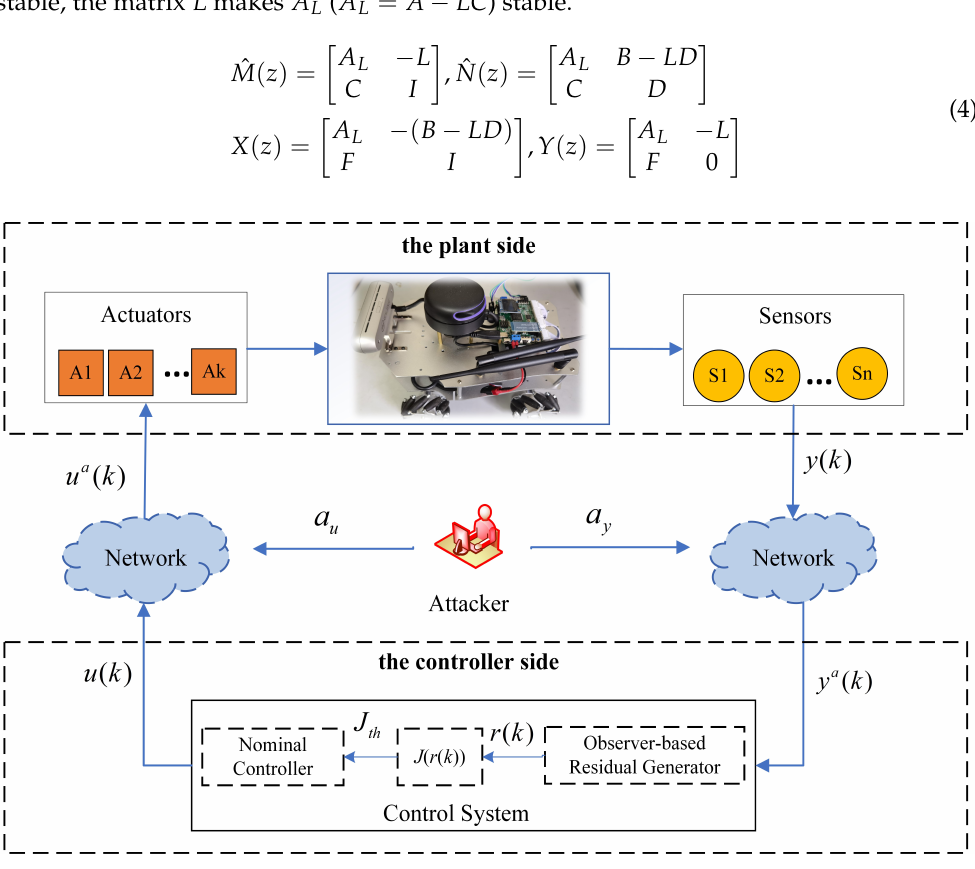
Figure 1. Communication and control system structure of